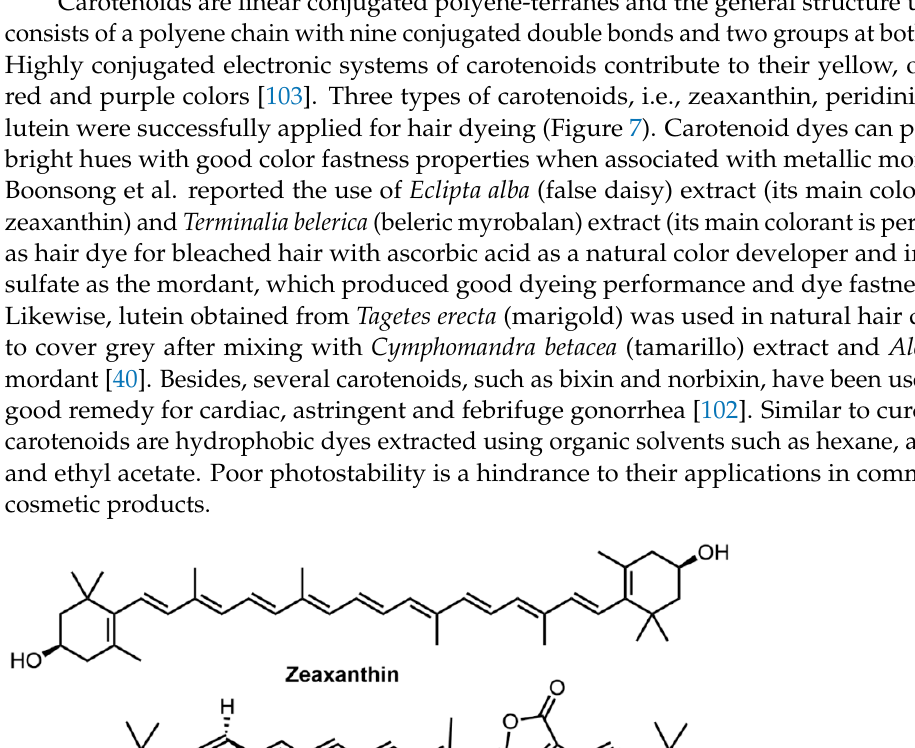
Figure 6. Molecular structures of the main types of curcuminoids.